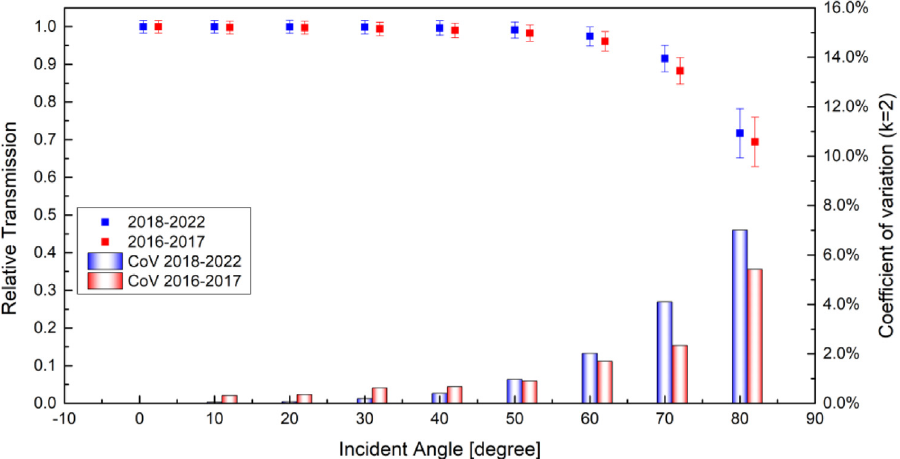
Fig. 5. Variation of relative angular transmission for PV modules manufactured in different years. Bars represent the standard deviation of technology variation ( k =2).